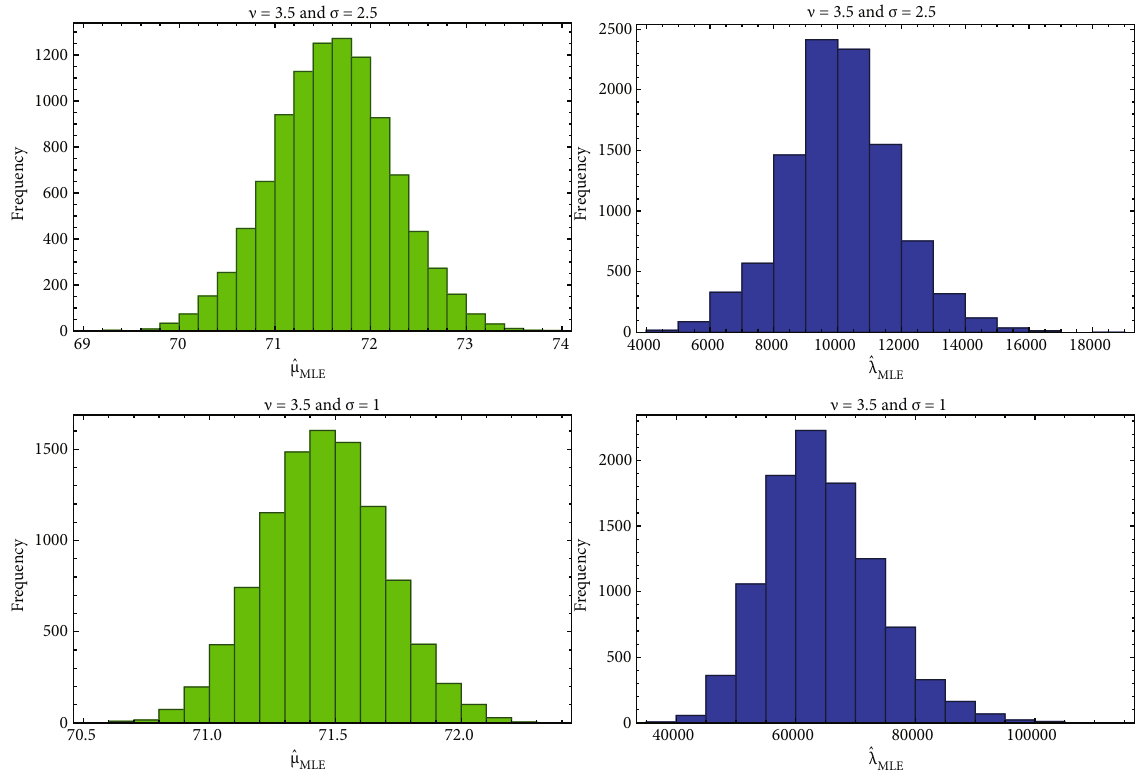
b λ and for n = 100 . MLE MLE